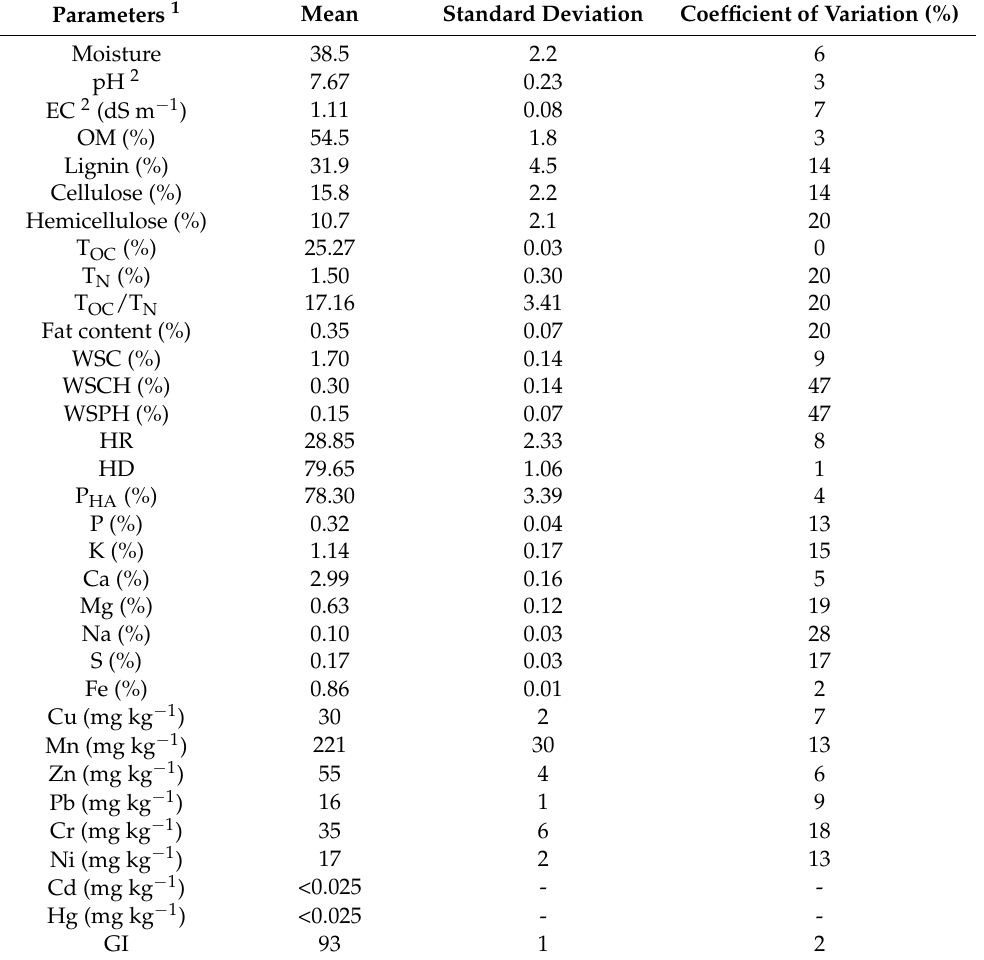
Table 1. Main agrochemical characteristics of the AL